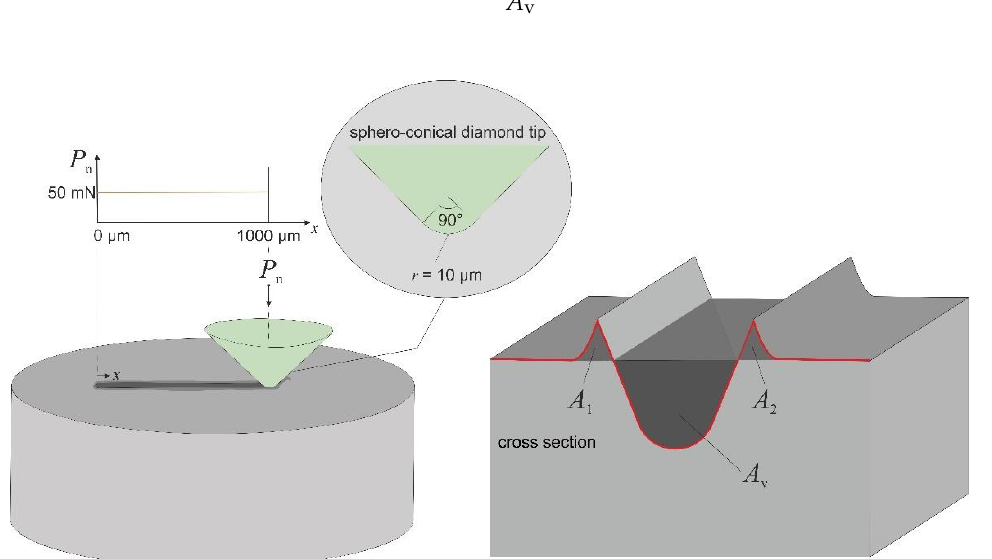
Figure 4. Schematic illustration of the spheroconical diamond indenter scratching the material surface with a constant normal load of 50 mN. The f ab parameter is calculated by the area of the scratch groove furrow A v and the areas A 1 and A 2 caused by piled-up material, Equation (1).